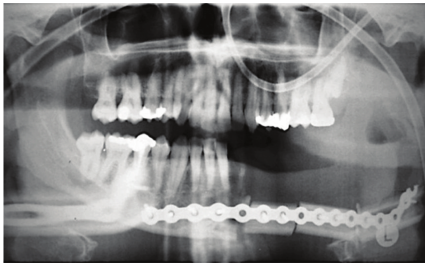
Figure 2: Immediately postsurgical treatment panoramic X-ray, which shows fibula free flap reconstruction of the